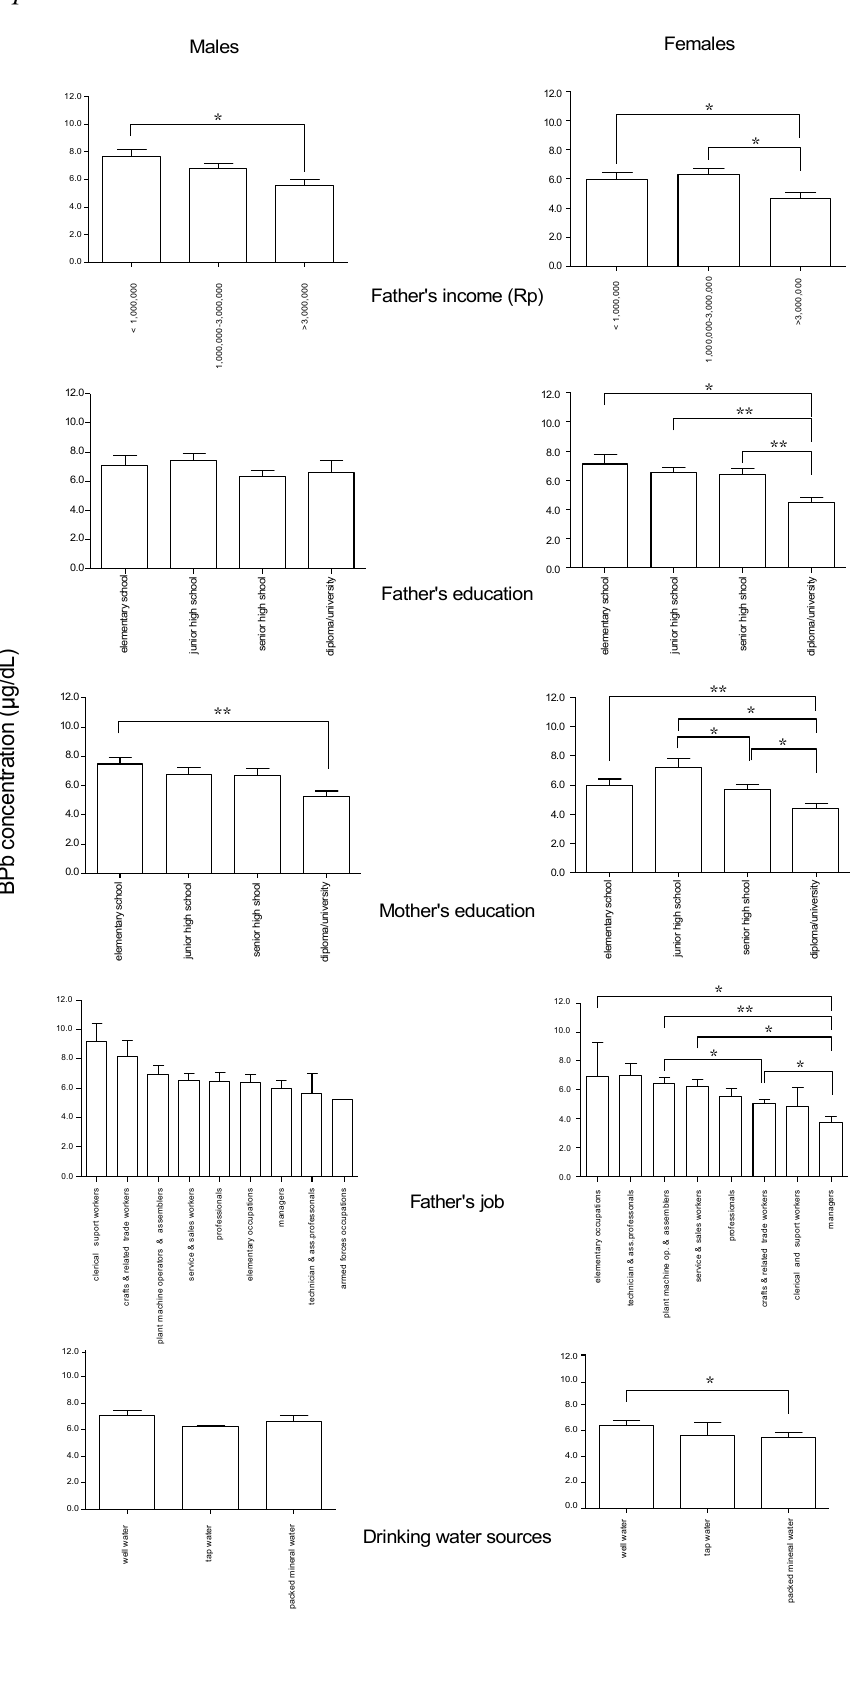
Figure 2. Significant differences in BPb concentrations according to socioeconomic characteristics in the male and female children. Rp: Rupiahs. Means with standard error bars. * p < 0.05, ** p <